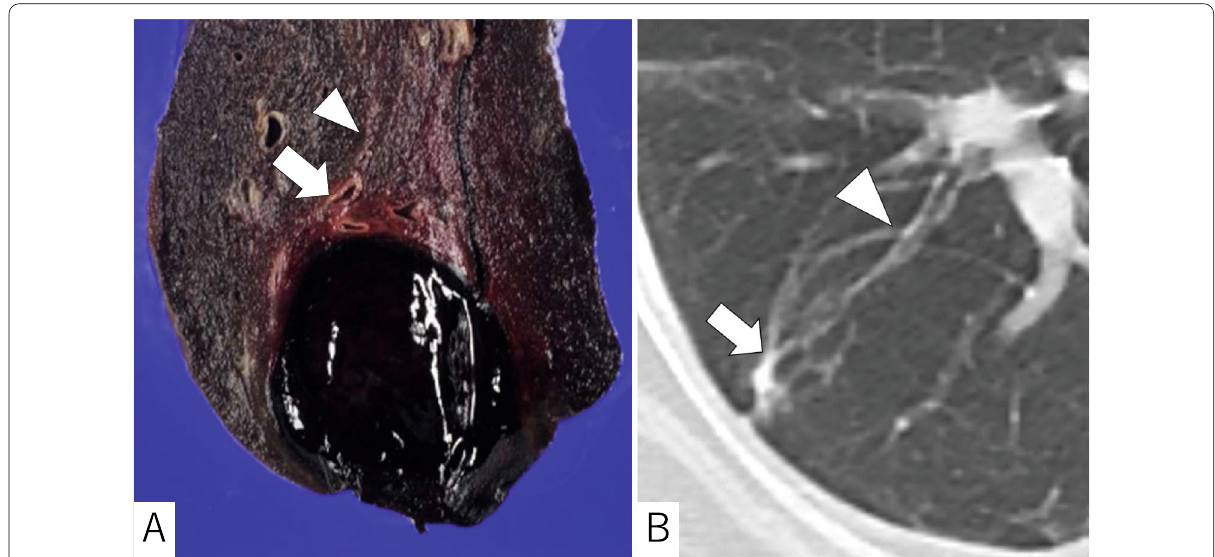
Fig. 3 A The cut surface of the specimen showing a focally dilated bronchiole (arrow) with a normal caliber proximal branch (arrowhead). The blood clot was deemed to have become dislodged from the dilated bronchiole. B A chest CT a year prior revealed a steep caliber change between the dilated (arrow) and normal caliber bronchiole (arrowhead)